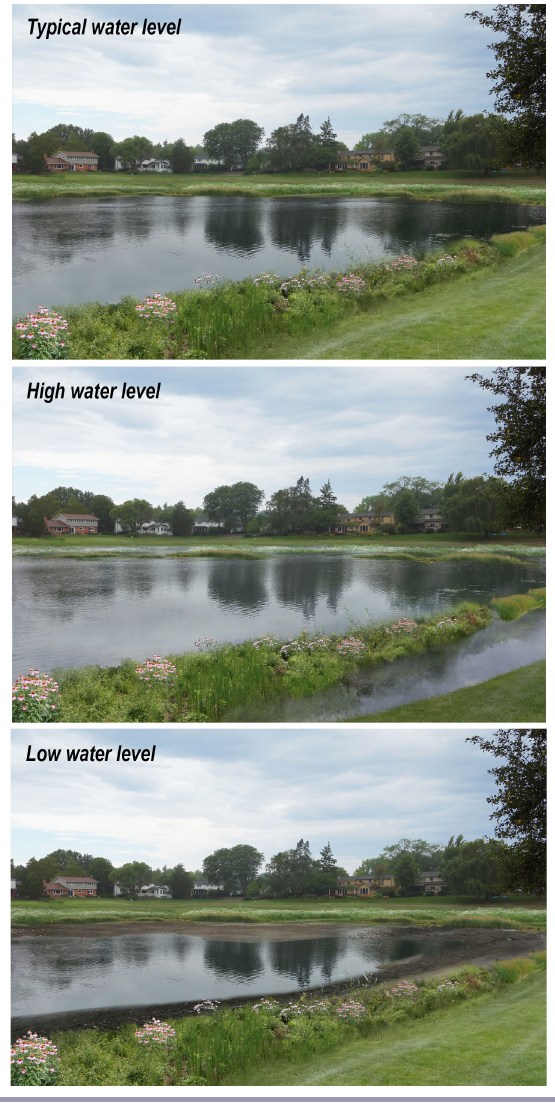
Fig. 1 . An example of smart nature-based solutions (sNBS): a retention pond in a residential area that is managed by a smart stormwater system. The pond was depicted with different water levels: (1) typical, (2) low, as if the pond were drained 24 hours before a storm to free up storage capacity, and (3) high, as if water were retained at a higher than typical level for as long as 48 hours after a storm (visualizations by Yiran Shen and Yuanqiu